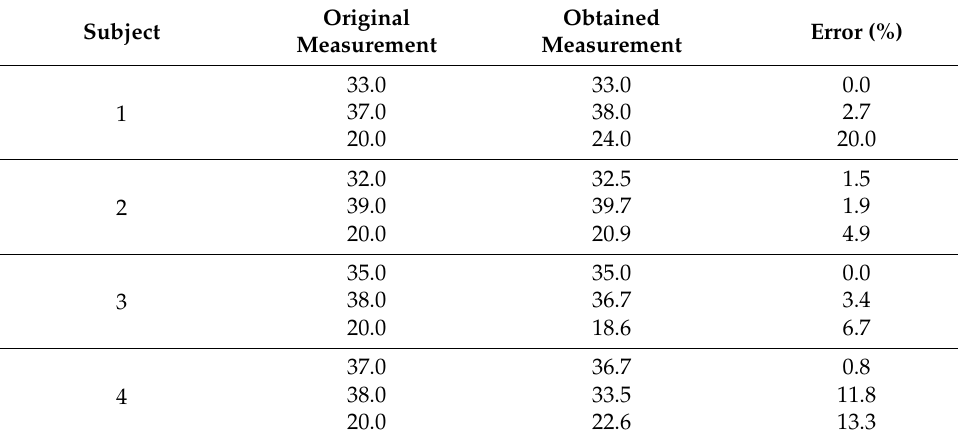
Table 1. Waist, lower hip, and thigh measurements for 12